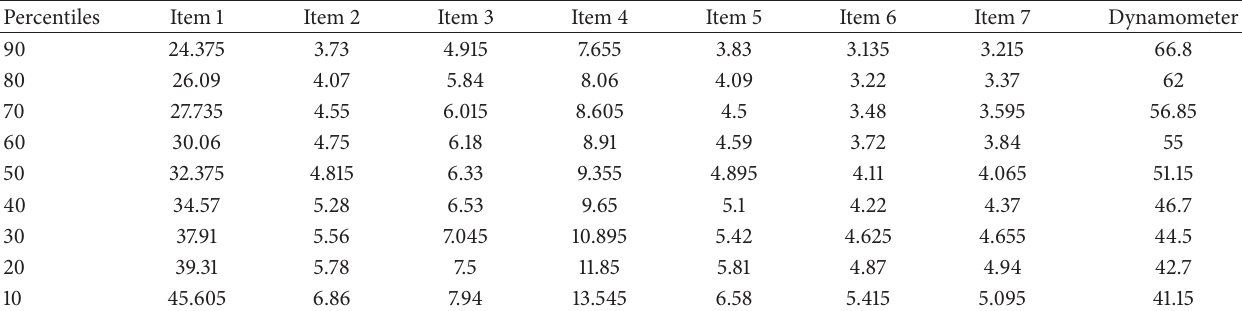
Table 13: 𝑛 = 34 , females, 20–94, nondominant hand, educational instruction: degree.